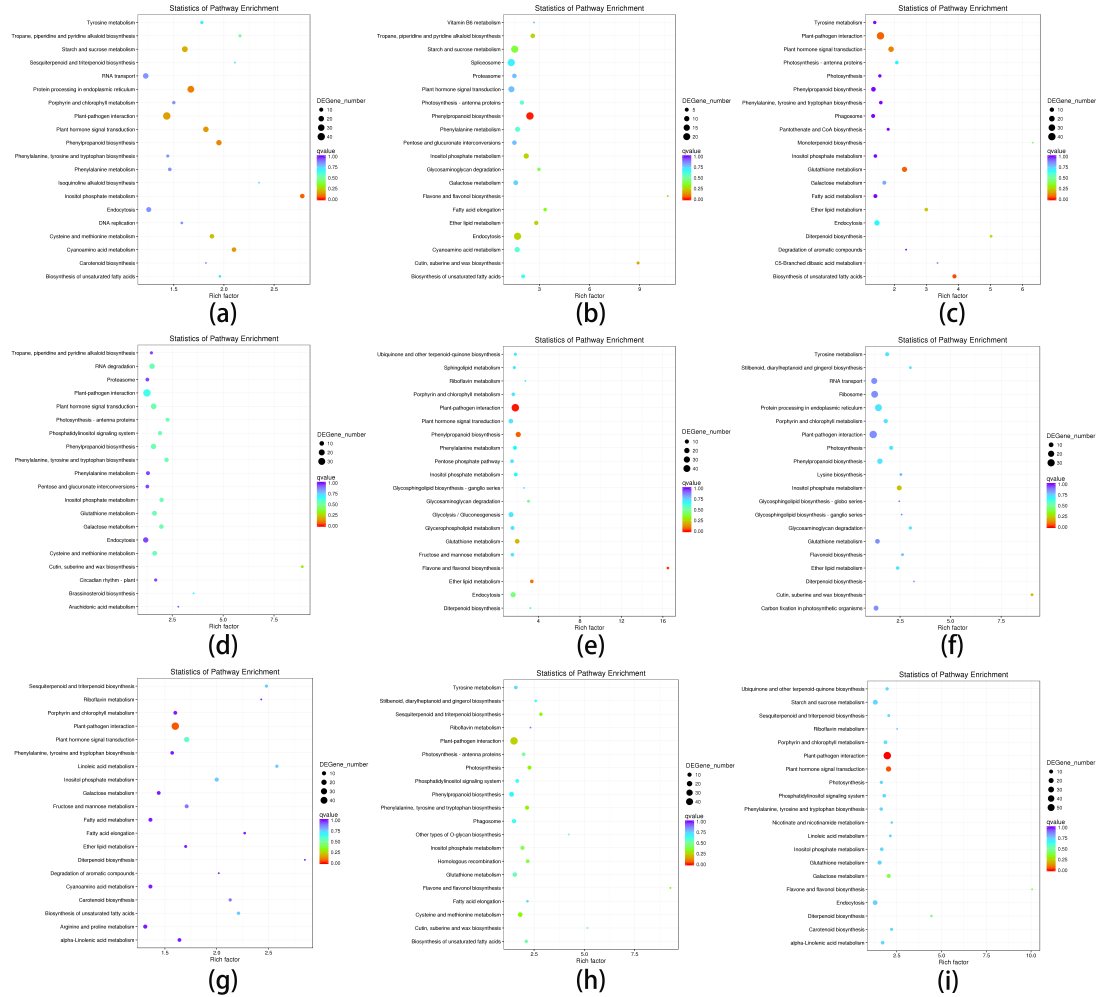
Figure 3. Pathways enriched among the identified DEGs. ( a – i ) Enriched KEGG pathways among the DEGs in response to the red, blue, green, LD8h, LD11h, LD14h, LI2, LI4, and LI6 light treatments, respectively. Pathway names are provided on the vertical axis, whereas the enrichment factor is presented on the horizontal axis. The size of each point indicates the number of DEGs in a particular pathway, whereas the color of each point corresponds to the Q score